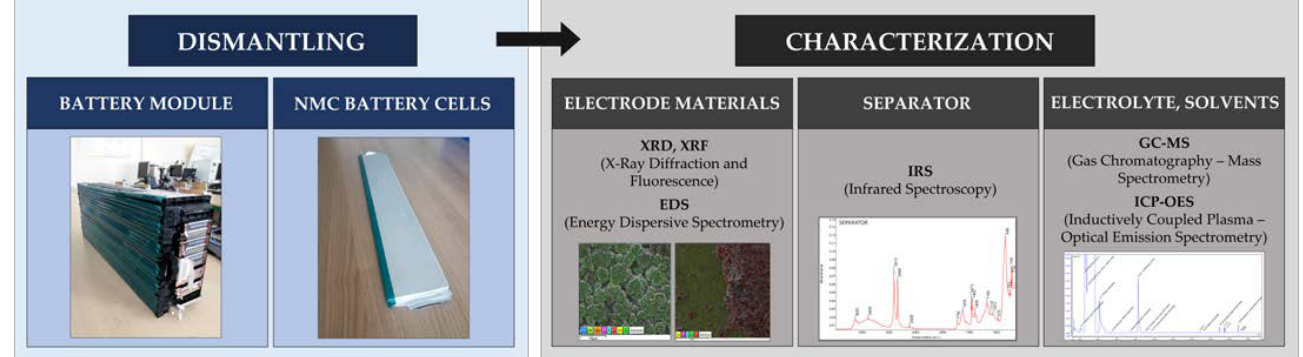
Figure 2. Material analysis methods used for battery cell characterization.